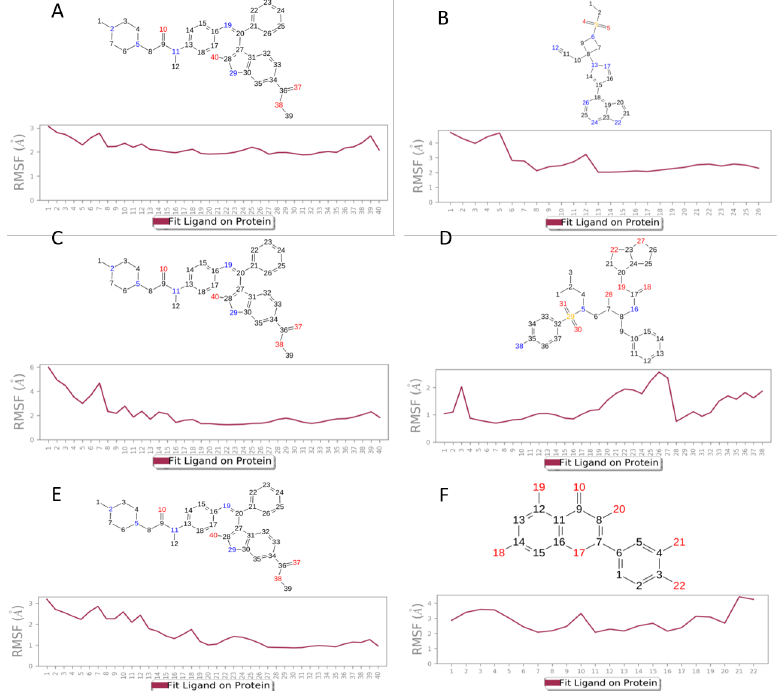
Figure 5. Ligand root means square fluctuation (RMSF). ( A , B ): Nintedanib and Baricitinib on ACE2 Protein, PDBID: 6M1D; ( C , D ): Nintedanib and Darunavir on M pro , PDBID: 5R82; ( E , F ): Nintedanib and Quercetin on Spike Protein. PDBID: 1ZV8.